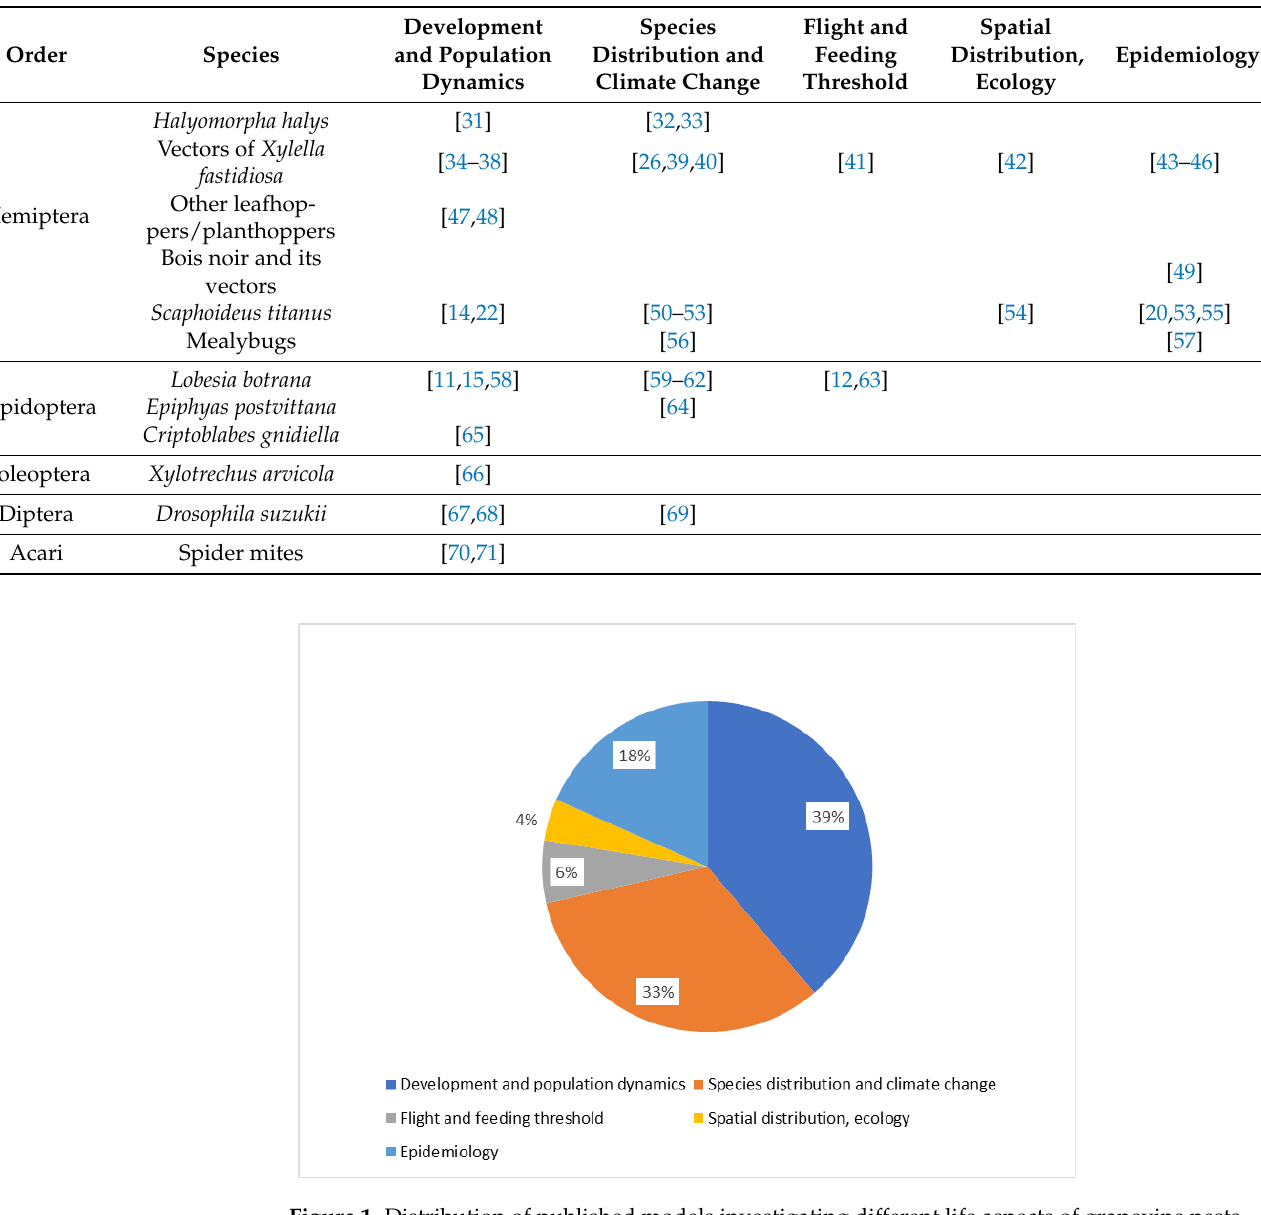
Figure 2 . Distribution of published models investigating different taxa of grapevine pests. 4.1. Case Study 1: Grapevine Yellows and Their Vectors Diseases caused by phytoplasmas, commonly referred to as “yel- lows”, transmitted by insect vectors are among the most threatening to grapevine. Since so far there is no cure, particular attention has been paid to vector control. The most important are Flavescence dorée (FD) and Bois noir (BN), which are transmitted by different vector species [21]. From a modelling point of view, we can distinguish between mod- els referring to aspects of vector biology only and models that encom- passes both disease and vector. The majority of models are about FD and/or its main vector S. titanus . The first models concerning S. titanus aimed to forecast the appear- ance of nymphs and adults. Rigamonti et al. [22] developed a stochastic